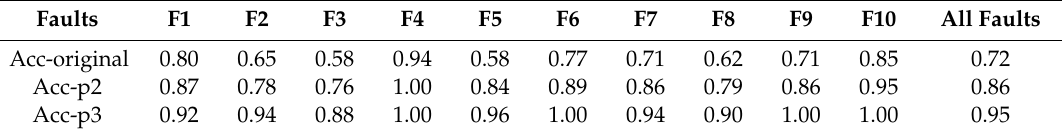
Table 9. Comparison of the original accuracy and probability accuracy.